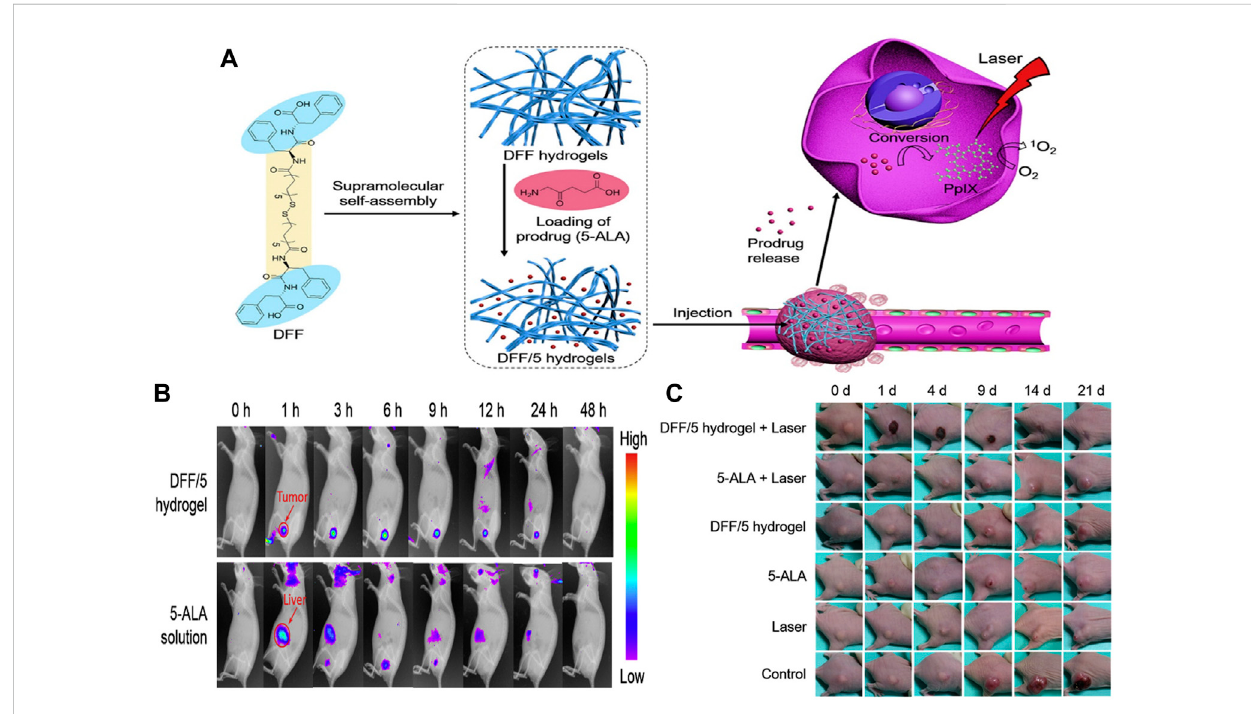
FIGURE 8 (A) Design and mechanism of GSH responsive DFF/ALA hydrogels; (B) Fluorescence images of mice at different time points after injection of DFF/ ALA hydrogels and free ALA; (C) Images of tumor-bearing mice at different time points after treatments. Adapted from ref. (Zou et al., 2020).